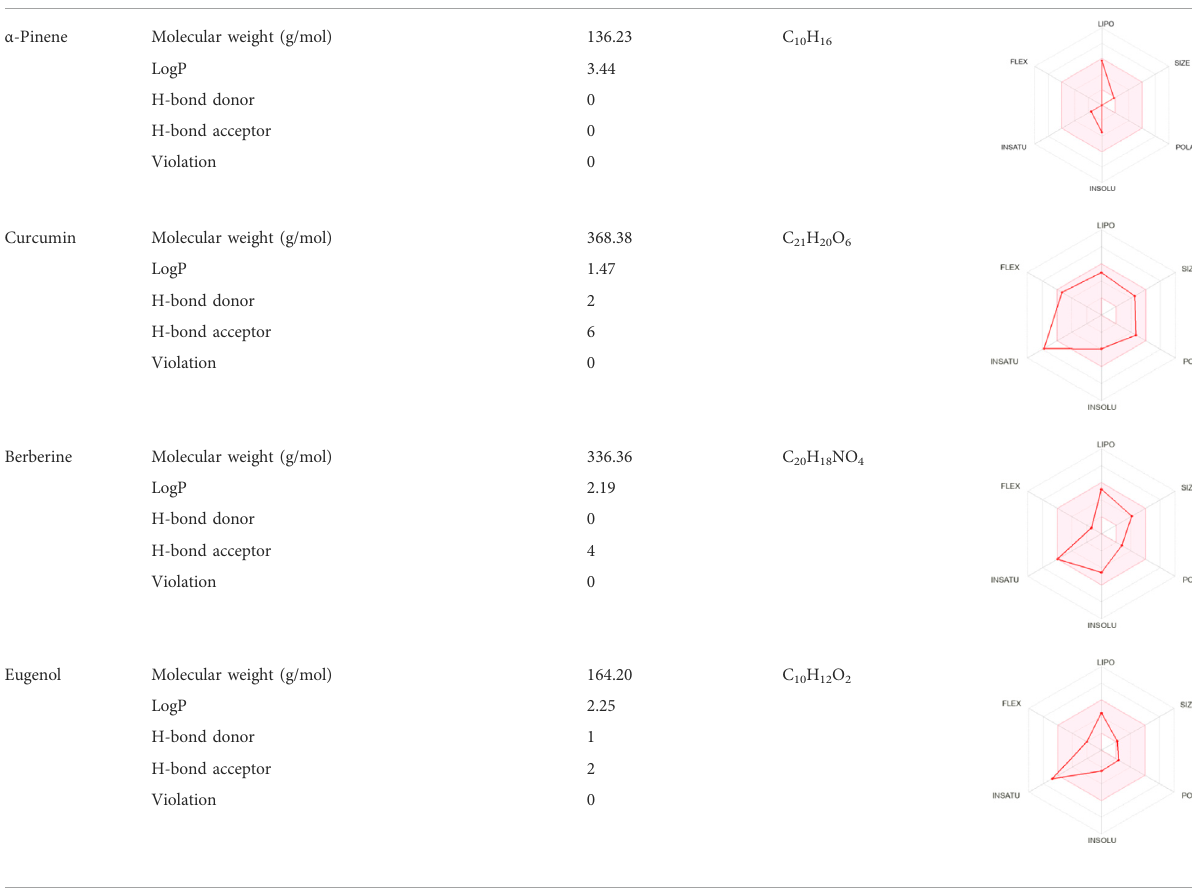
TABLE 4 Physicochemical analysis of potential inhibitors of THR and VelB proteins of C. lunata . Compounds ADME properties (Lipinski ’ s Rule of Five)